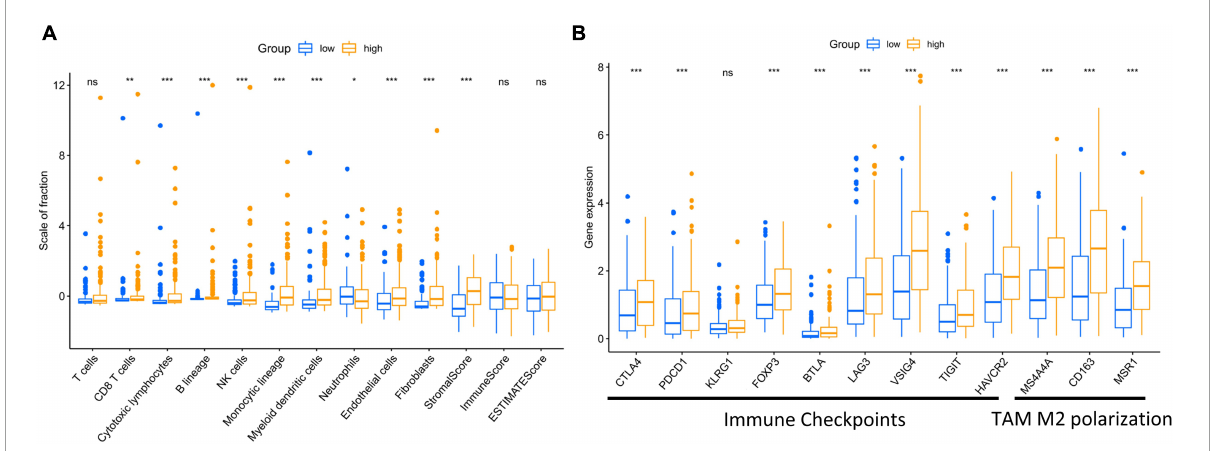
FIGURE4 High risk score affected the infiltration of stromal and immune cells in tumor microenvironment, aggravating immunosuppression. (A) Different infiltration of stromal and immune cells was observed regarding risk score of the present model. (B) Immune checkpoint markers and type M2 tumor-associated macrophages markers were exhibited regarding risk score of the present model. p < 0.05 was considered statistically significant. symbol *, **, ***, ns mean P -value < 0.05, 0.01, 0.001, and no significance